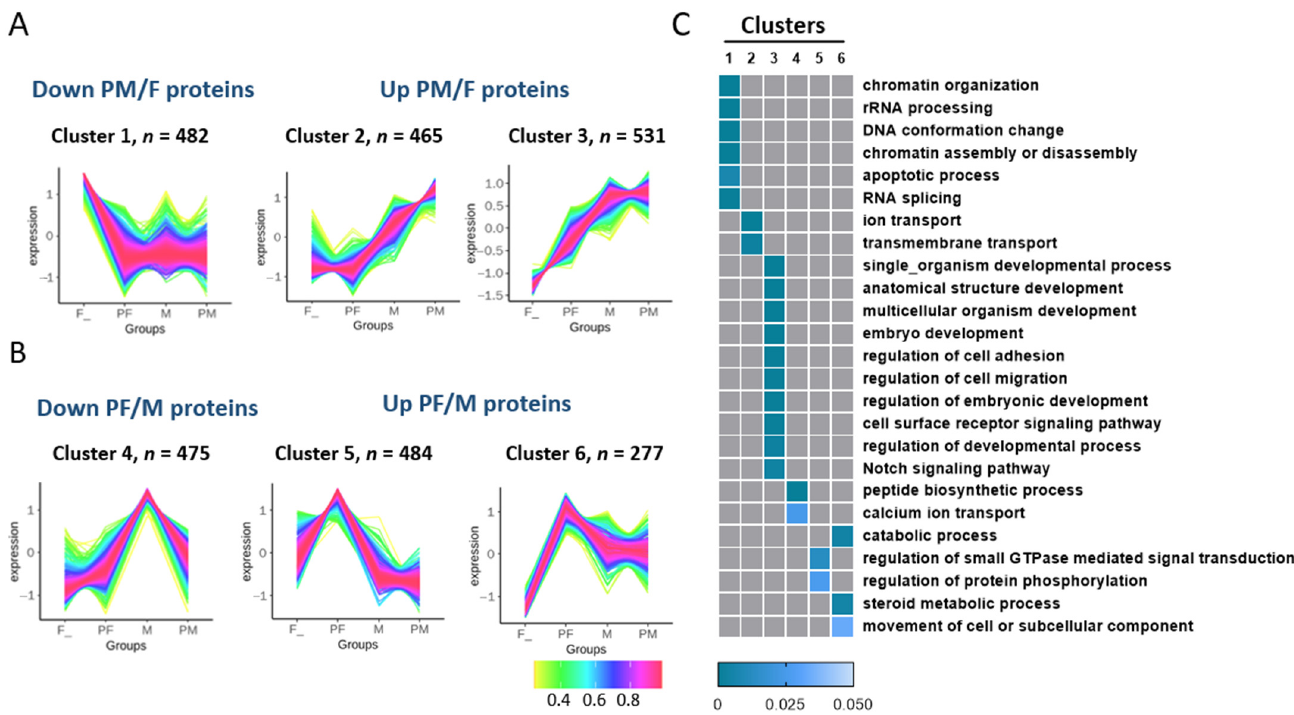
Figure 6. Cluster analysis of differentially abundant proteins among four types. ( A , B ) Fuzzy c- means clustering of regulated proteins with different kinetic profiles. Each line indicates the relative abundance of each protein. ( C ) Functional annotations of proteome clusters by GO. The GO biological process terms are displayed in heat maps, according to their statistical significance ( p < 0.05) and locations on the GO tree.